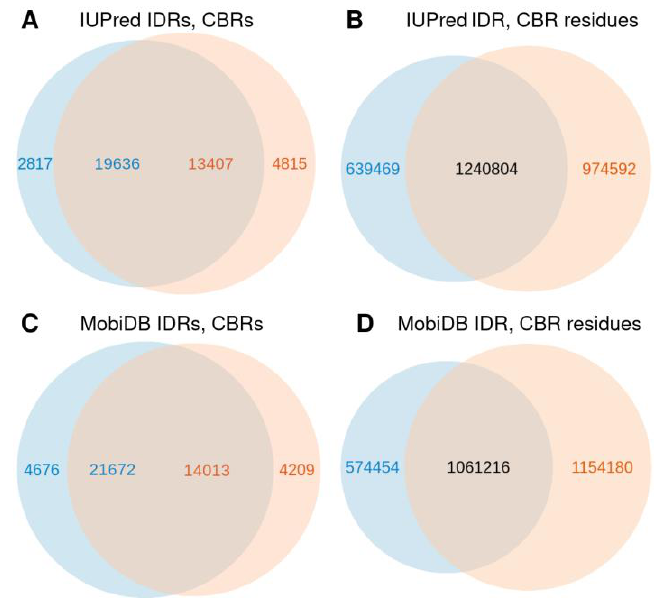
Figure 2. Overlap between CBRs and IDRs described by Venn diagrams. ( A ) By regions with IUPred predictions. ( B ) By residues with IUPred predictions. ( C ) By regions with MobiDB-lite predictions. ( D ) By residues with MobiDB-lite predictions. A given residue could be in multiple CBRs because CBRs of different types might overlap, but such residues were only counted once. IDRs do not overlap each other by definition. Note that the numbers of CBRs and IDRs overlapping (in A or in C ) are different because a region of one type may overlap multiple regions of the other type.